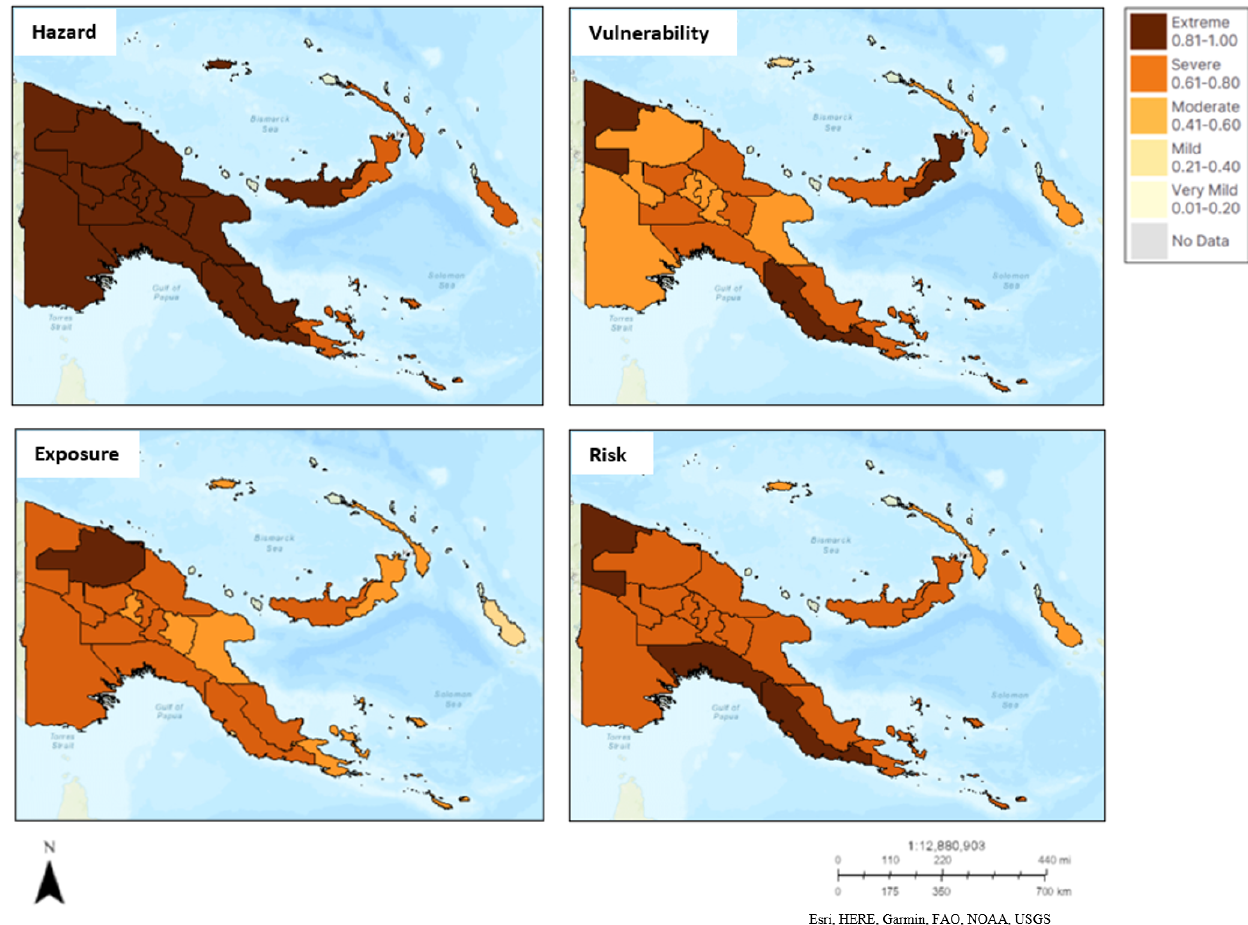
Figure 6. Overall drought risk maps of PNG provinces for 2015 including a drought hazard, drought vulnerability, drought exposure, and drought risk map detailing the index level of each province. The index level is classified on a deepening orange colour scale from very mild (index values from 0.01–0.20) to extreme (index values from